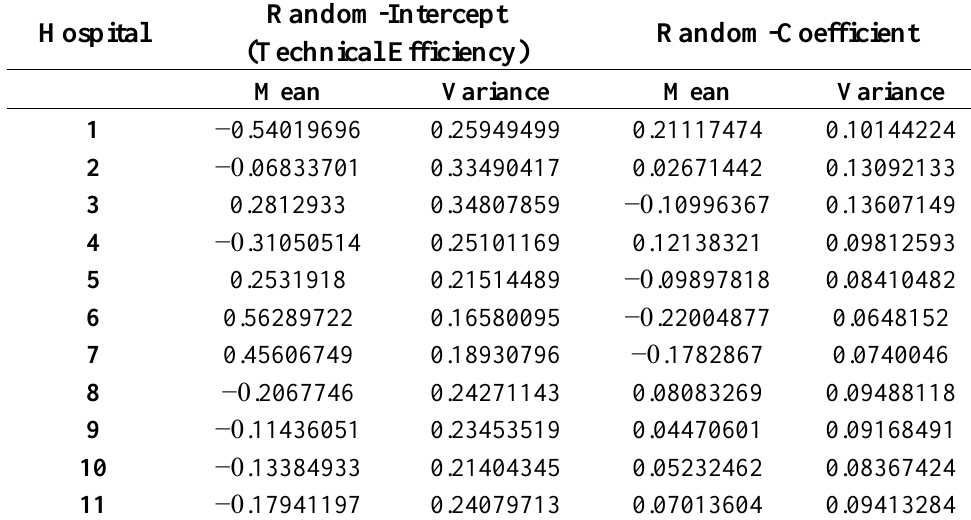
Table 3. Technical efficiency corresponding to liver and kidney